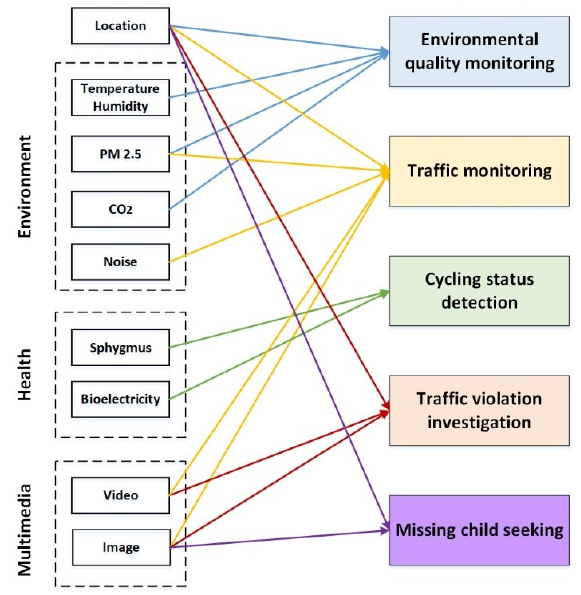
Figure 12. Application scenarios and data correlation in